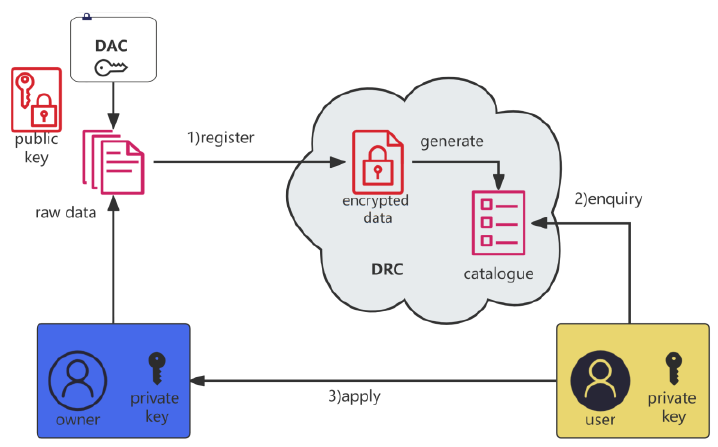
Figure 3. Data encryption registration process.